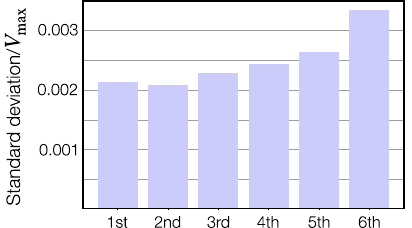
FIG. 8. rms deviation of the individual bands for the NN used to produce Figs. 1 – 3 and